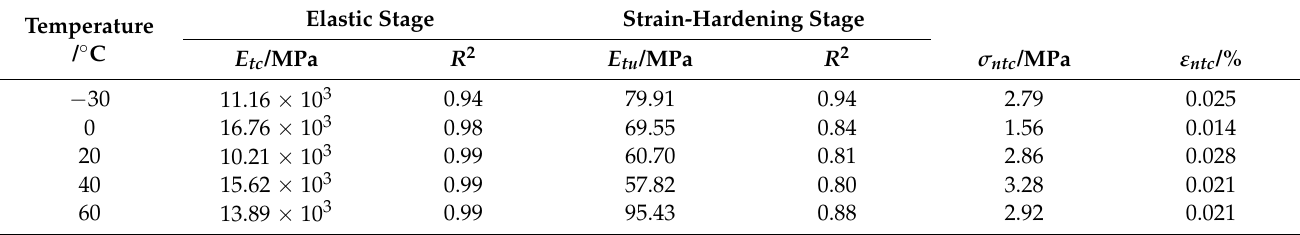
Table 7. Calculation parameters of simplified model of tensile stress–strain relationship for HDC.